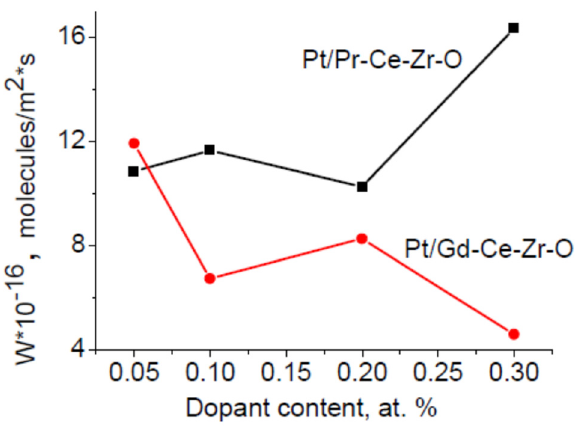
Figure 4. Specific rate of H 2 production in autothermal reforming of acetone for Pt/Pr x (Ce 0.5 Zr 0.5 ) 1-x O 2-y and Pt/Gd x (Ce 0.5 Zr 0.5 ) 1-x O 2-y catalysts.